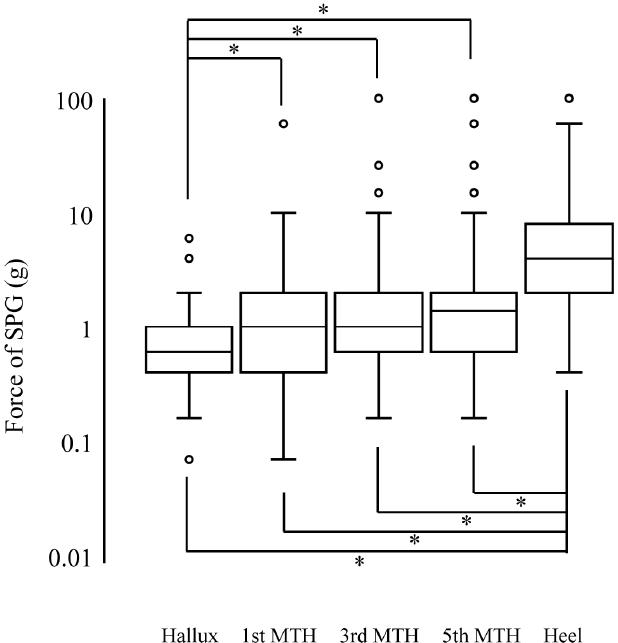
Figure 2. Comparison of the smallest perceivable grade (SPG) of healthy young adults at the hallux; 1st, 3rd, and 5th metatarsal heads (MTH), and heel. The SPG was converted to logarithms of the force (g) that each filament can apply, as measured and labeled by the producer. The symbol ◦ is indicates an outlier. *, p < 0.05.